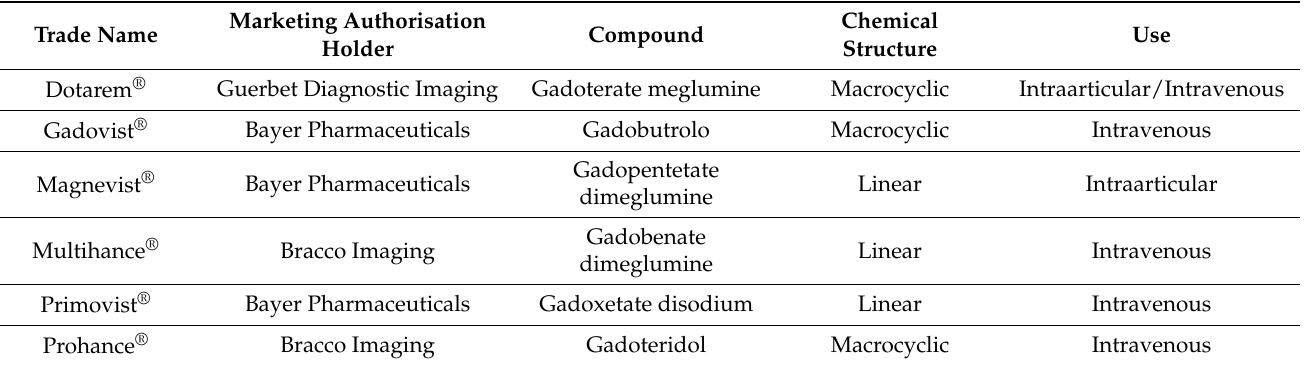
Table 1. Commercially available gadolinium-based contrast agents (GBCAs) in Europe approved during